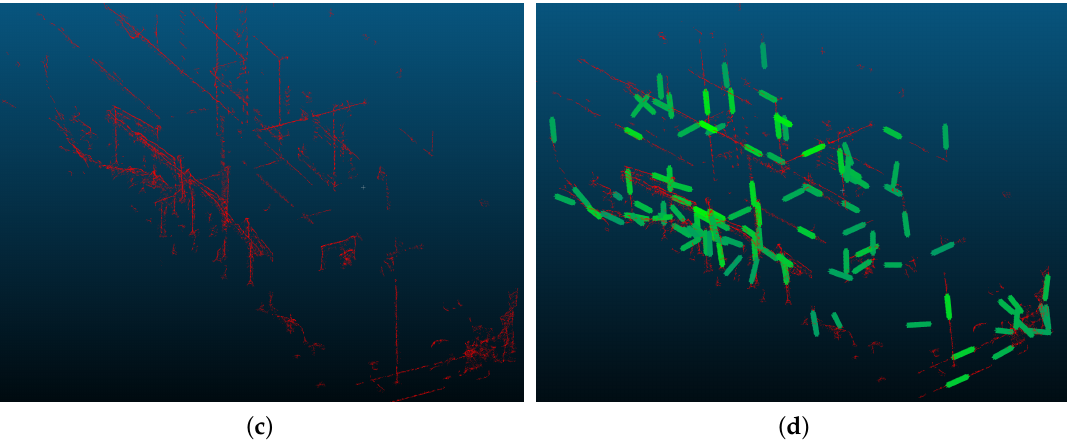
Figure 2. Outline of line detection: ( a ) Original point-cloud scan, ( b ) Point-cloud after convolution with Gaussian kernel, ( c ) Result of sharp features extraction and subsequent filteration by StatisticalOutlierFilter, ( d ) Line detection after edge detection phase. A green unit length marker indicates the corresponding line has been detected. Note that it does not depict any information about line length which is ignored in our